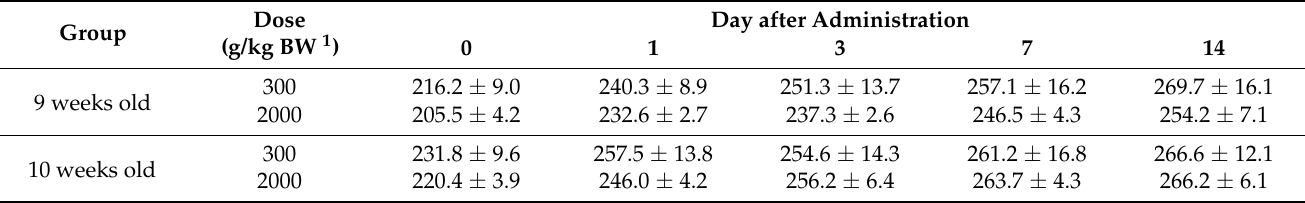
Table 11. Body weight changes in rats administered B . subtilis